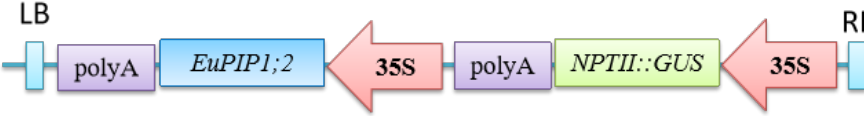
Figure 1. Schematic illustration of the pSH- 35S-EuPIP1;2 expression vector.